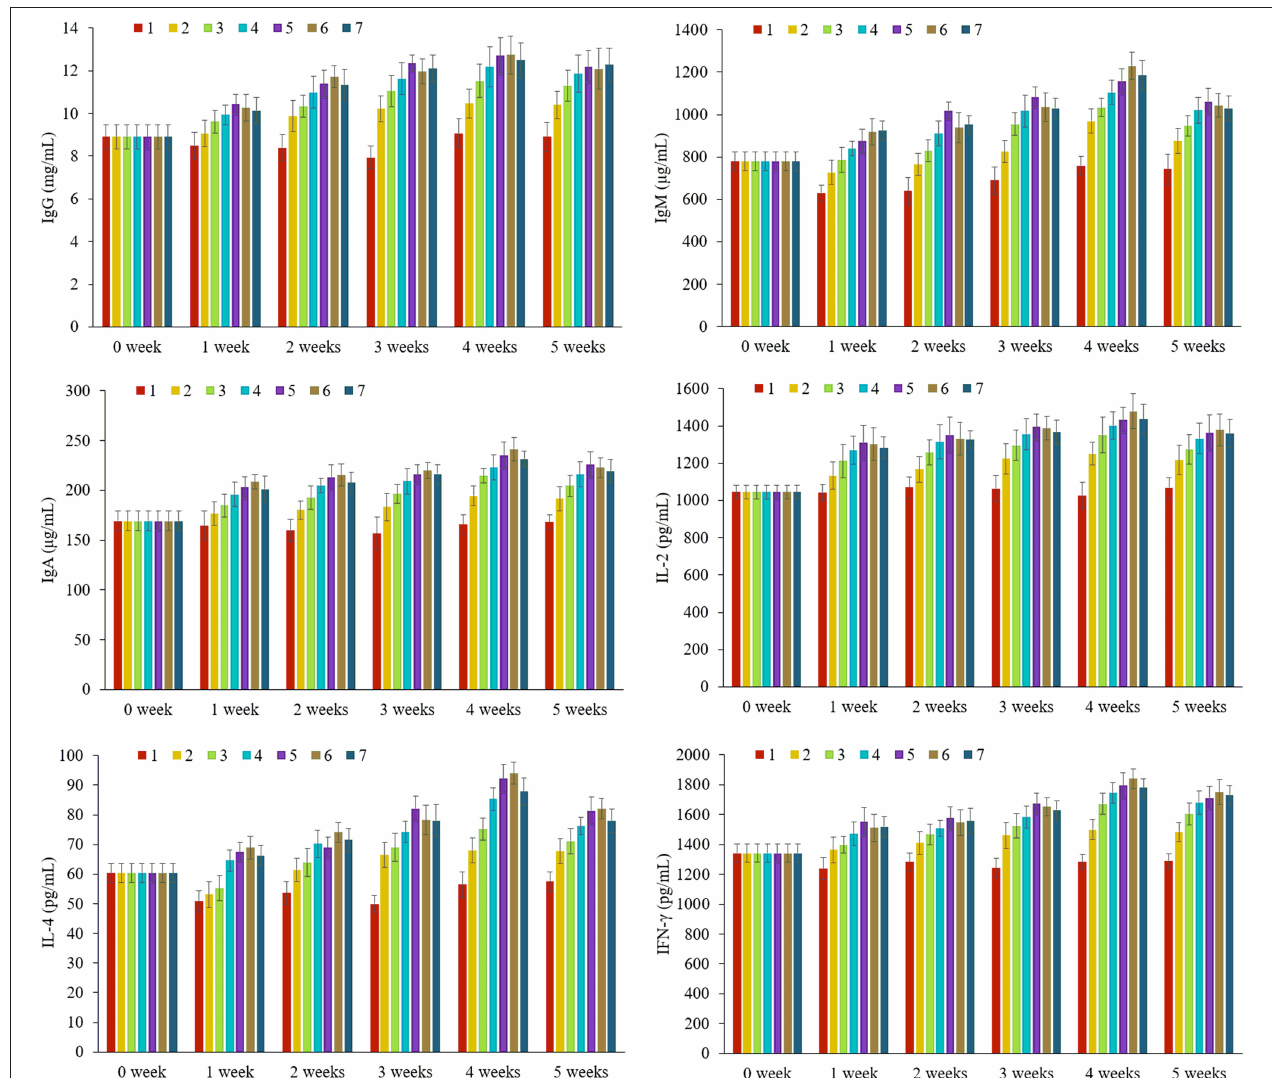
FIGURE 2 | The contents of tested immunoglobulin M (IgM), immunoglobulin G (IgG), immunoglobulin A (IgA), interleukin (IL)-2, IL-4, and interferon- γ (IFN- γ ) in different groups at 0–5 weeks, n = 8 per each group. 1: Blank control, 2: former type, 3: new-L, 4: new-M, 5: new-H, 6: new-C, 7: new-MC.